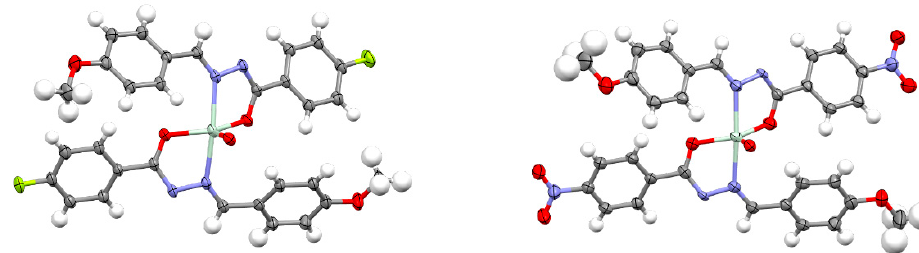
Figure 5. Thermal ellipsoids representation of Ac1 (on the left ) and Ac2 (on the right ) drawn at 50% probability Ortep representation. Atoms are color-coded as follows: carbon (brown), hydrogen (white), oxygen (red), nitrogen (blue), zinc (light gray), fluorine (yellow).